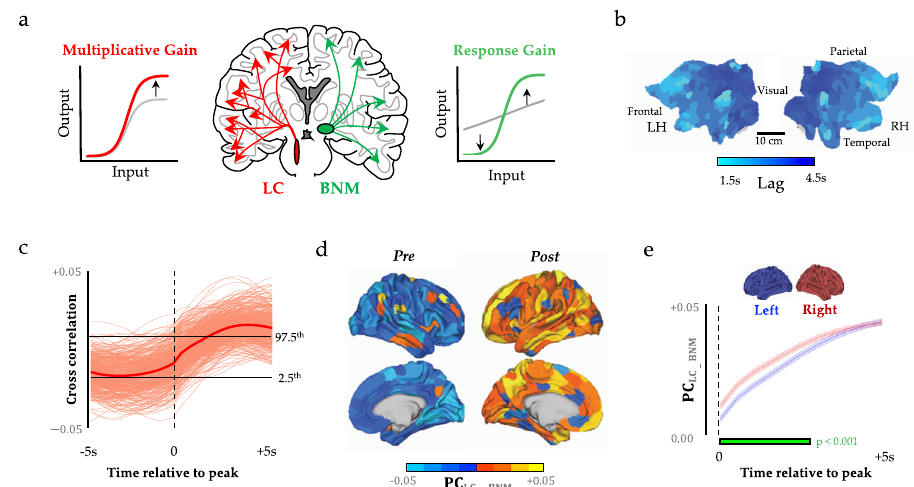
Fig. 1 Sympathetic activity precedes network-level integration. a Regional time series were extracted from the subcortical locus coeruleus (red), which is thought to alter multiplicative gain, and the basal nucleus of Meynert (green), which is thought to alter response gain, and they were compared to cortical BOLD signal and topological signatures during the resting state. b We observed an anterior-to-posterior travelling wave (velocity ~ 0.13 m s − 1 ) following peaks in τ LC-BNM , which are shown on both the left (LH) and right (RH) hemispheres of a cortical fl at map (and v.v. following peaks in τ BNM-LC ). c Lagged cross-correlation between τ LC (cid:1) BNM and PC for each parcel (faint line) and mean PC (solid line); dotted line depicts the zero-lag correlation, and the black lines depict the upper (lower) bounds of the block-resampled null model 95% CI. d Mean cortical participation coef fi cient (PC) preceding (left) and following (right) the zero-lagged τ LC (cid:1) BNM value, only the right hemisphere is shown, which is mirrored for Post. e Mean participation coef fi cient following peak τ LC (cid:1) BNM was higher in the right (red) vs. the left (blue) hemisphere (error bars represent mean± SEM, n = 200 parcels within a hemisphere, p < 0.001 green bar one-sided permutation test 5000 random